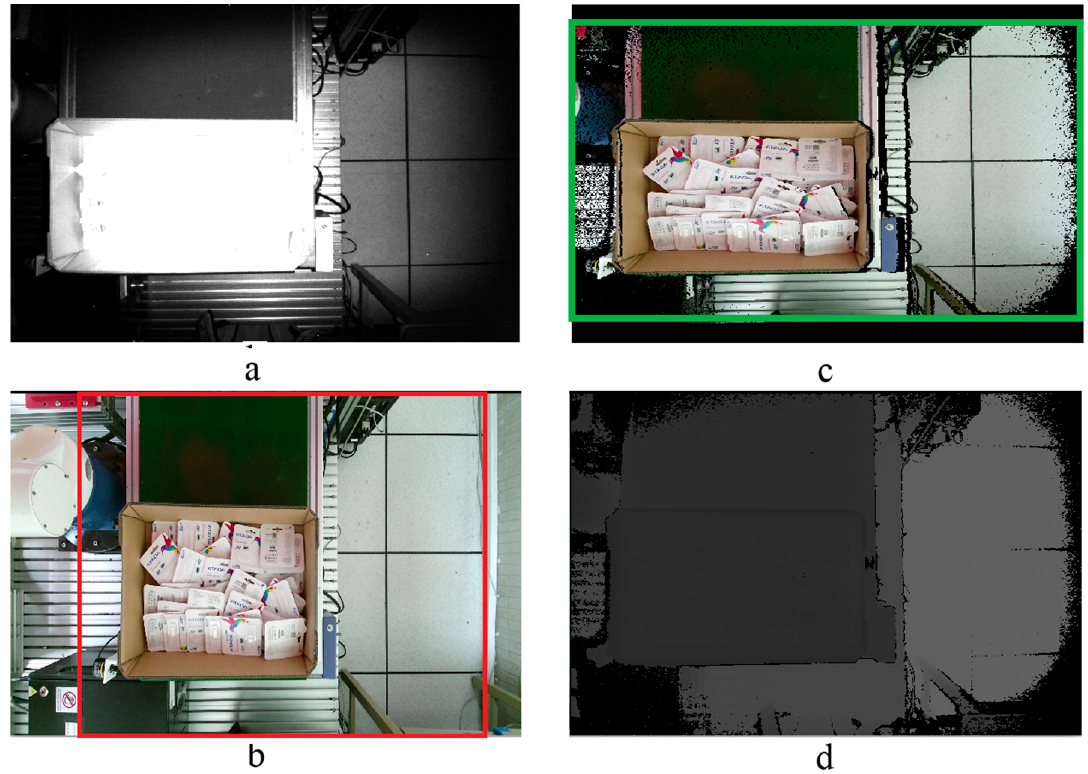
Figure 10. ( a ) IR image, ( b ) original image, ( c ) registered color image and IR obtained from transformation and cropping, ( d ) depth image.